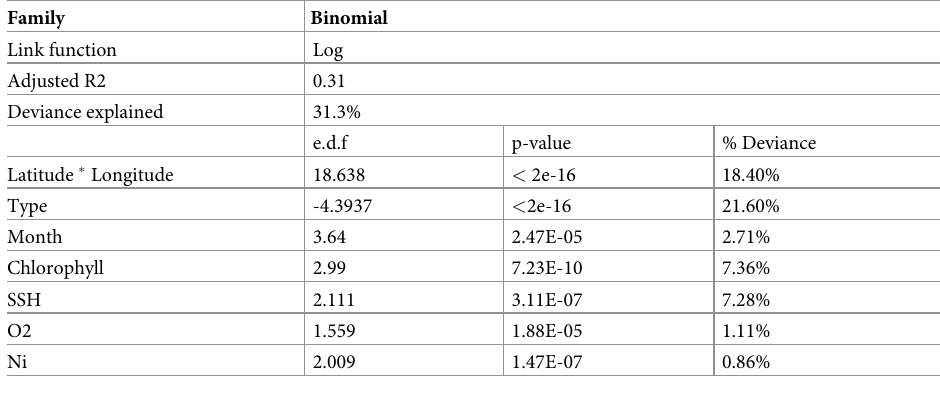
Table 2. Summary results for the final Generalized Additive Model (GAM) selected to model the presence